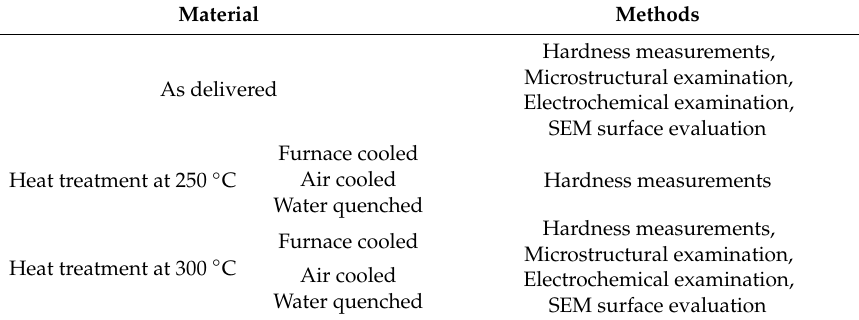
Table 1. Scheme of the research